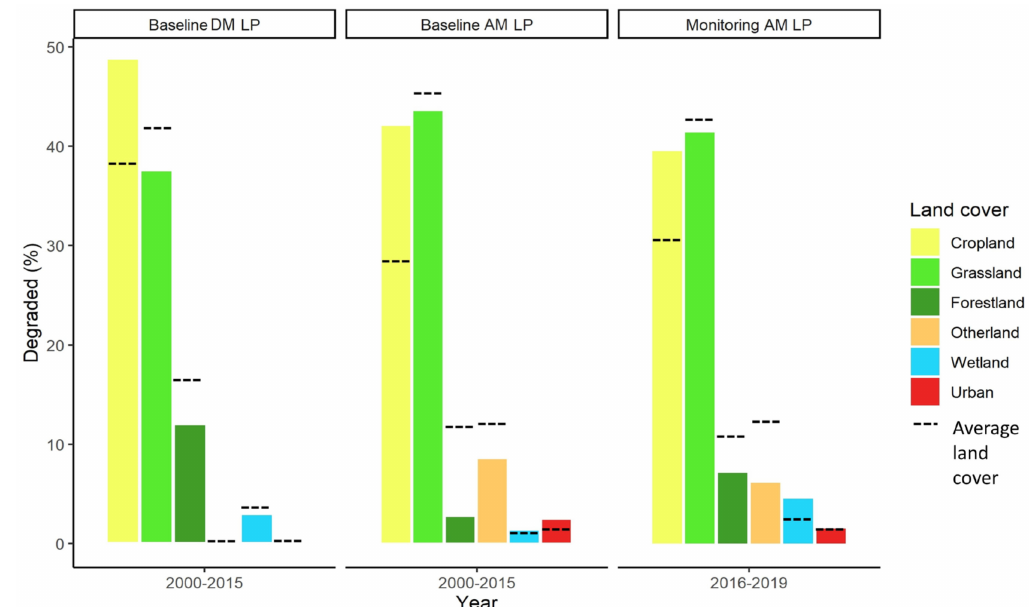
Figure 5. The bar chart showing the distribution of land productivity (LP) decline sub-indicators over the land cover classes using the default (DM) and adapted methods (AM). The dashed lines show the actual land cover